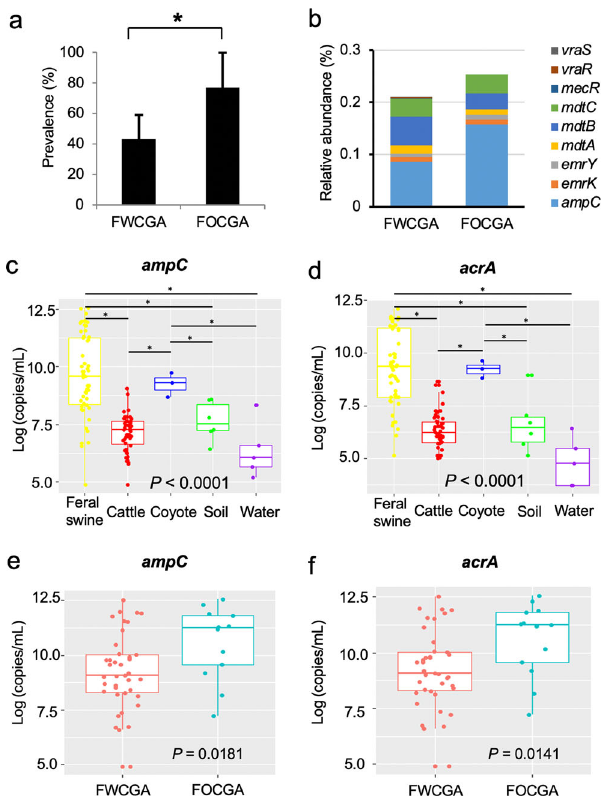
Fig. 7 Proportion of antimicrobial resistance in FWCGA, FOCGA, and cattle. a The prevalence of CRBs in FWCGA and FOCGA. An asterisk indicates a statistical difference ( P < 0.05) of each category comparison by Chi-Square test. b Relative abundance of antibiotic resistance genes in FWCGA and FOCGA. c Abundance of ampC gene in cattle, wildlife, and the environment. d Abundance of acrA gene in cattle, wildlife, and the environment. e Abundance of ampC gene in FWCGA and FOCGA. f Abundance of acrA gene in FWCGA and FOCGA. Box plots display the median (center line), 25th and 75th percentiles (box) and 5th and 95th percentiles (whiskers) for each individual. Asterisks indicate a statistical difference ( P < 0.05) of each category multidrug resistance protein ( emrYK ), multidrug ef fl ux system ( mdtCBA ), methicillin resistant protein ( mecR 1), and vancomycin resistance proteins ( vraRS ) were identi fi ed. To further validate